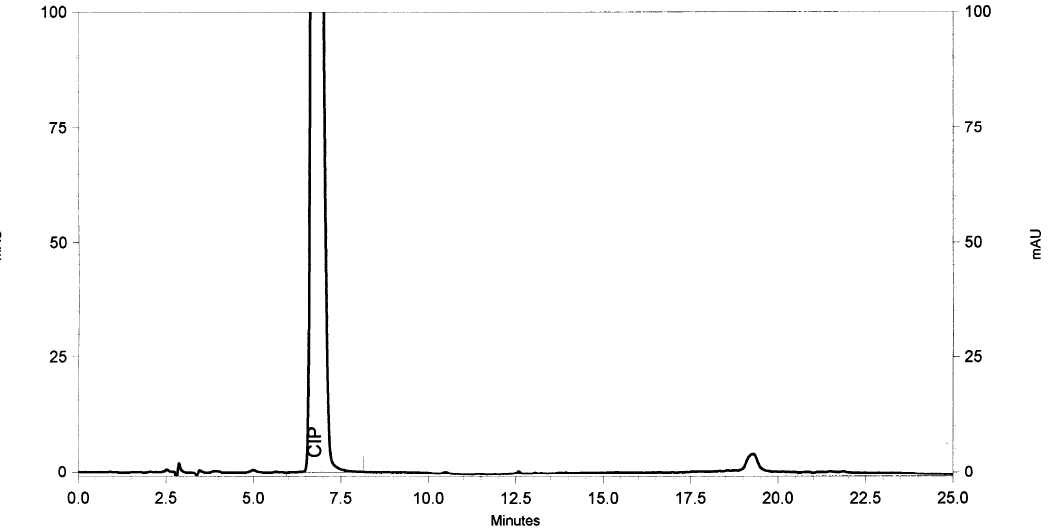
Figure 1. Chromatogram of the CIP standard solution at a concentration of 0.5 mM recorded at 277 nm.